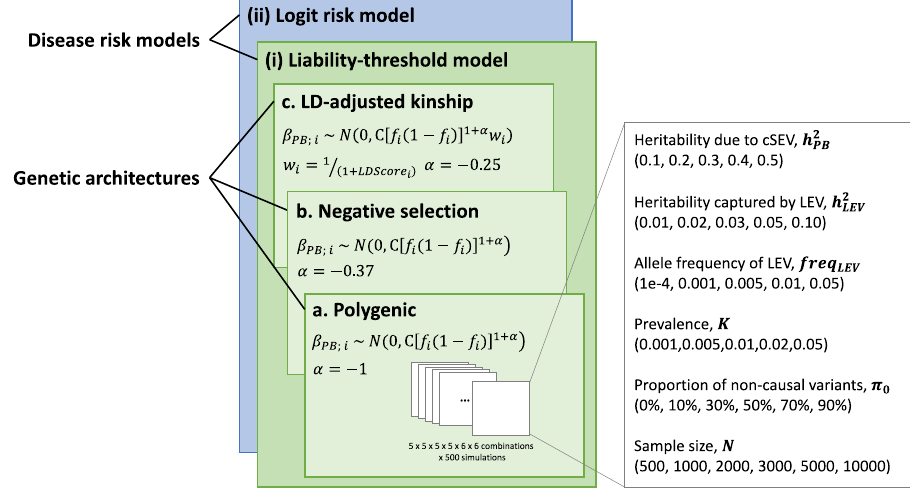
Fig. 2 Generative models of disease liability and various genetic architecture models. We calculated the disease risk probability assuming two models of disease liability, namely, the liability-threshold model (green panel) and logit risk model (blue panel). To simulate the effect sizes of common causal variants (and the resulting phenotypes), we considered three genetic architecture models: polygenic, negative selection, and LD-adjusted kinship. For each model of disease liability and model of genetic architecture, we varied the simulation parameters (the white panels), including the heritability h 2 due to the PB common-variant polygenic burden (PB), heritability h 2 captured by the (primarily rare) LEV and its allele frequency f , disease prevalence K , and sample LEV size N (as a study-design parameter). The chosen values are shown in the brackets under each parameter. In simulated data, we calculated the utility of the PB-LEV correlation. In addition, varying the proportion of noncausal variants ( π ) in the estimate of PB, we quanti fi ed the power to detect the PB-LEV 0 correlation. For each of the parameter combinations, we simulated 500 times to calculate the utility and power. These generative models of disease liability and genetic architectures provide the basis for a summary-statistics-based framework for inferences based on PB and variance explained by the LEV was fi xed, larger f yielded smaller effect size β , implying that when the effect size difference LEV between common and rare variants was smaller (i.e., the common and rare variants had more similar effects), the utility was lower. However, in the case of LEV allele frequency lower than 0.001, utility dropped, as the LEV might not be present in the sample.